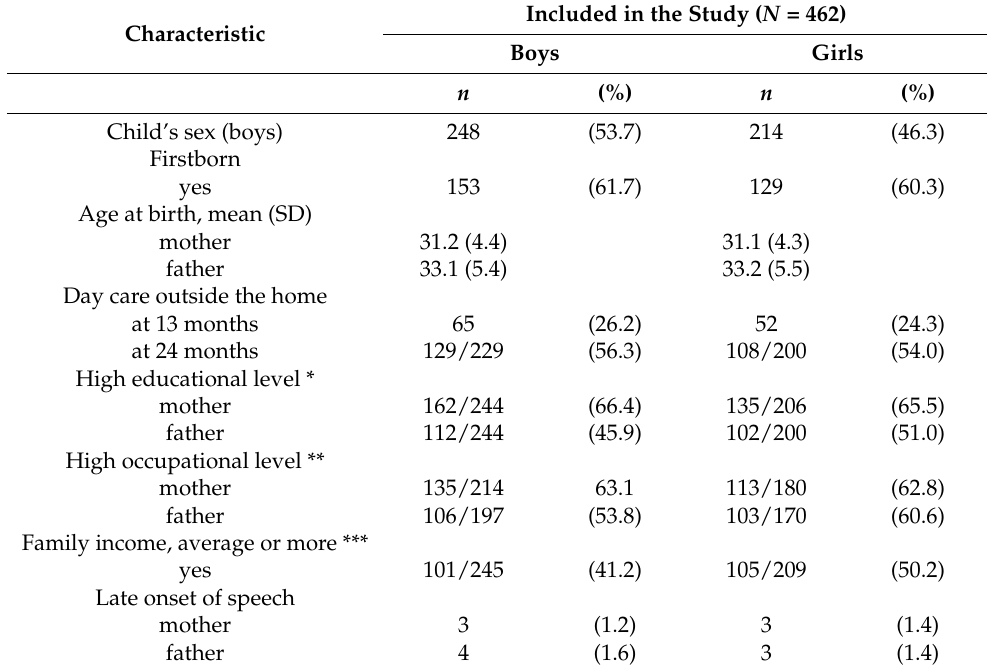
Table 1. Descriptive background characteristics of the study